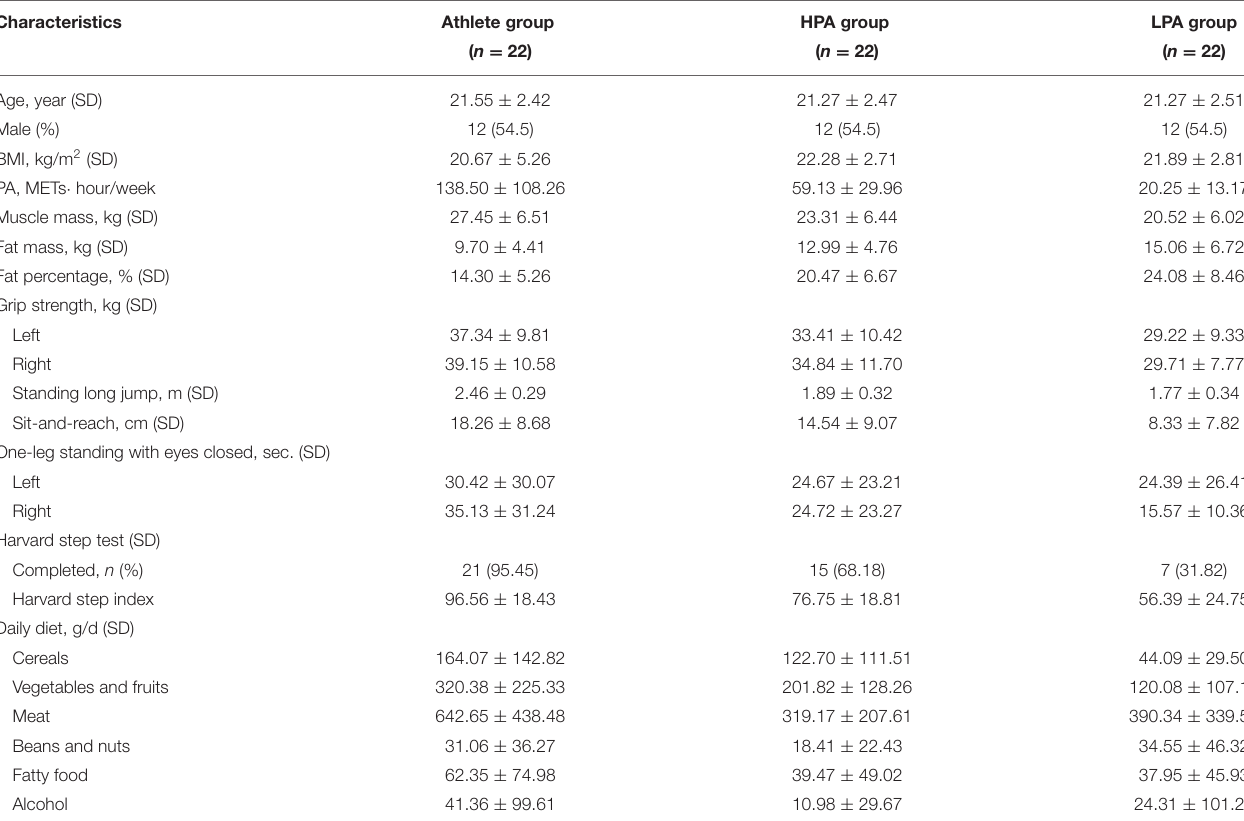
TABLE 1 | Characteristics of the participants.